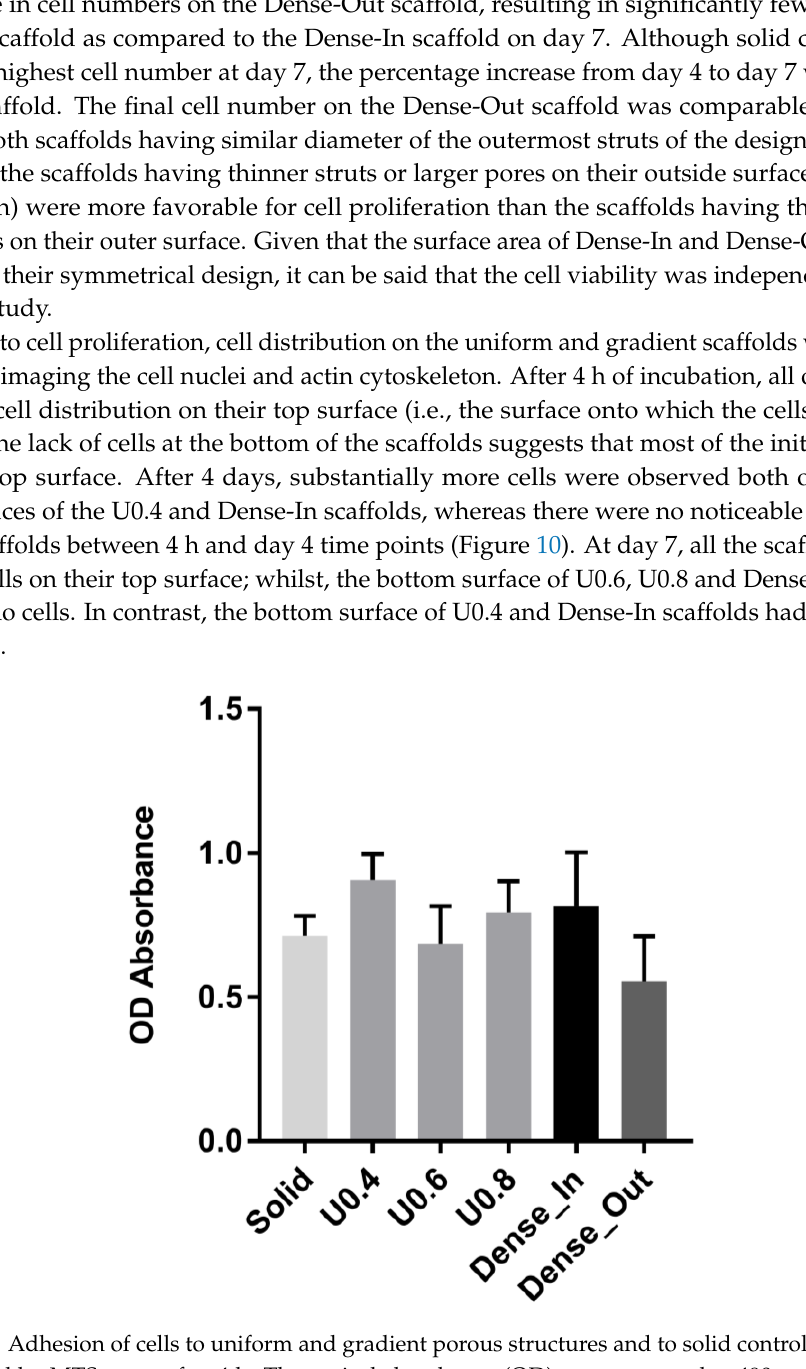
U0.8 scaffold (Figure 8), further extending the difference in cell number between the samples. For the